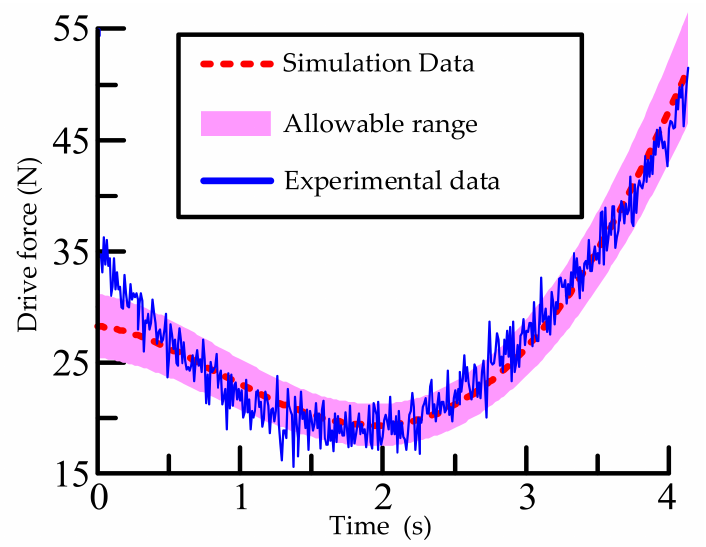
Figure 14. Comparison of the simulation and real situation for driving